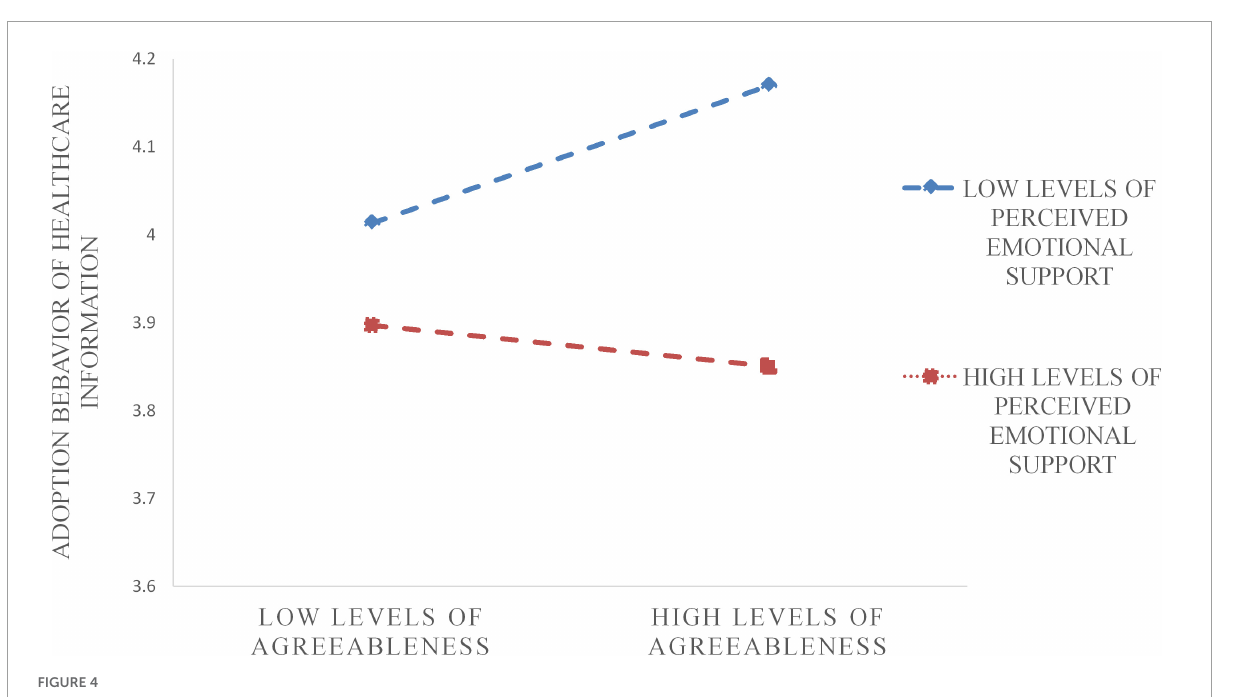
FIGURE4 Moderating effect of PES in the relationship between AP and